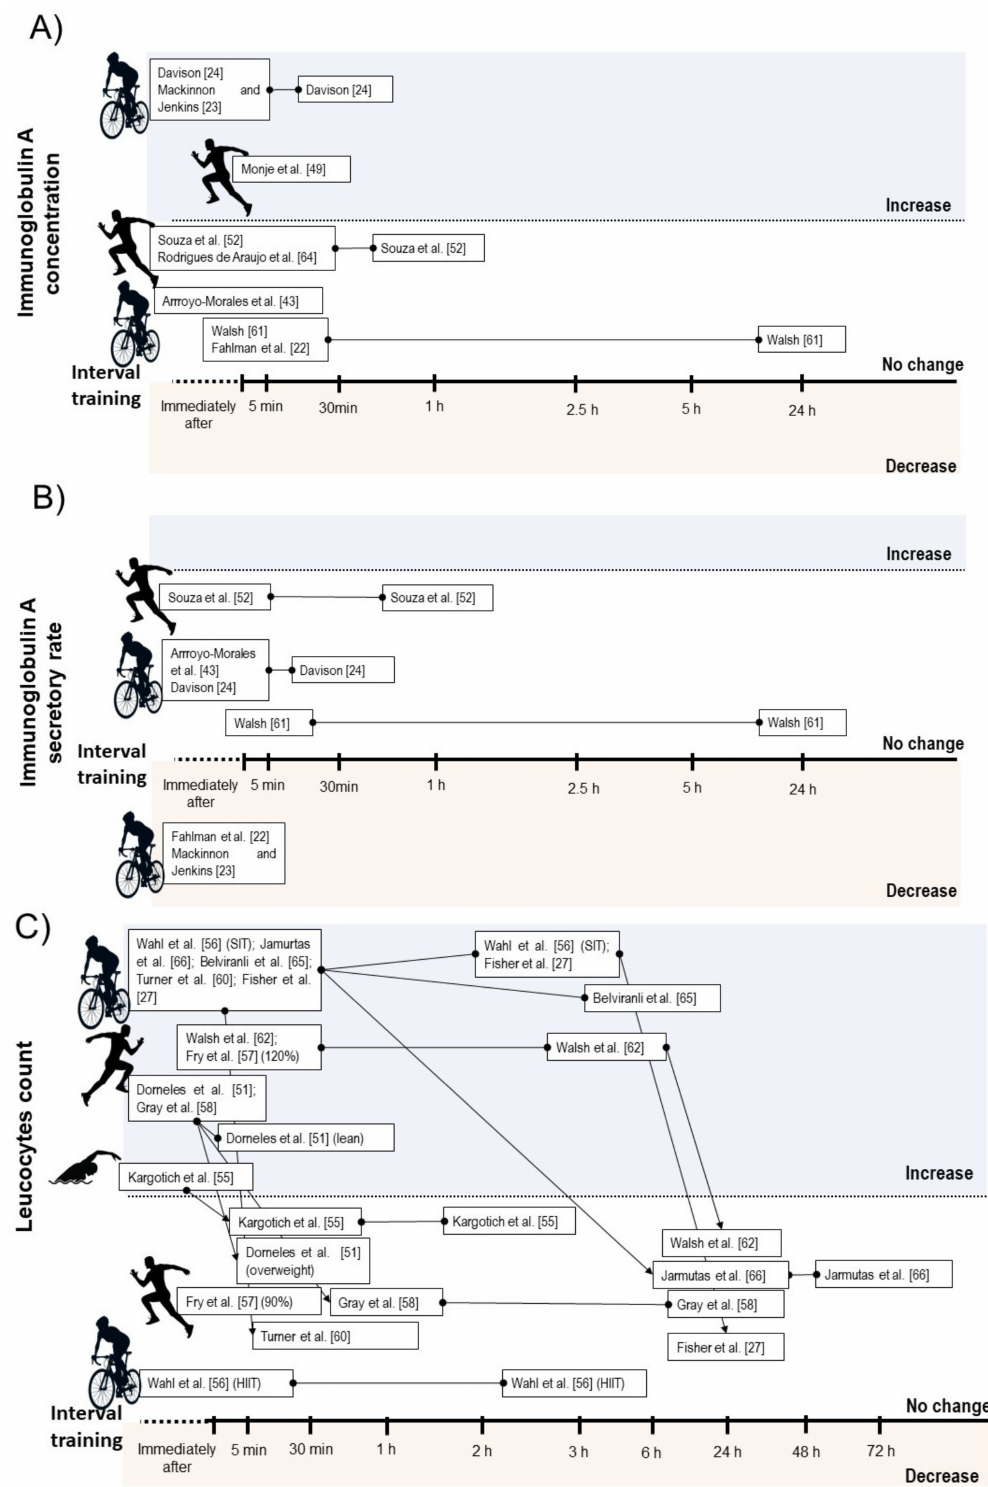
Figure 2. Illustration of time course of salivary immunoglobulin A concentration ( A ), salivary immunoglobulin secretory rate ( B ), and total leucocyte count ( C ) after acute interval training